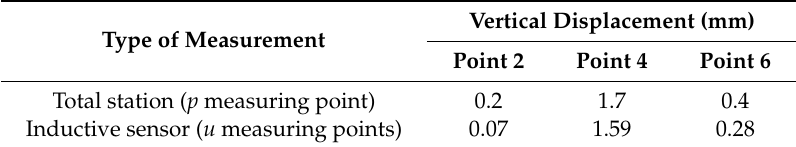
Table 1. Comparison of vertical displacements measured by means of total station and inductive sensors during S2 tests in the section